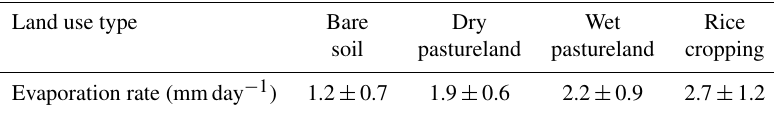
Indicated uncertainties are standard errors.